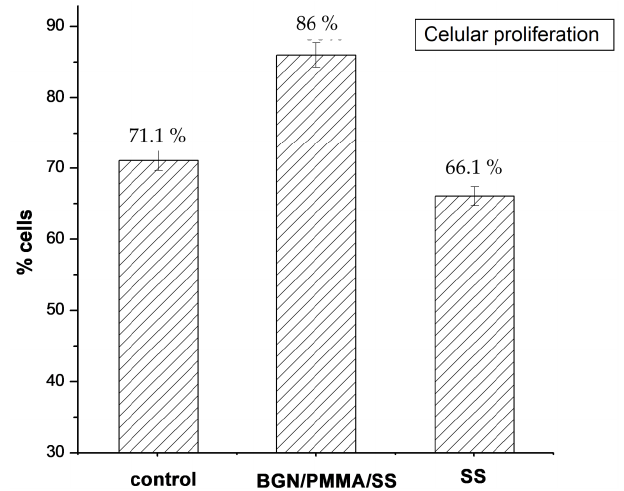
Figure 14. Proliferation of cells at passage 9 after 6 days from seeding on BGN / PMMA / SS and bare SS samples. Table 5. Antibacterial activity of the samples against Staphylococcus aureus and Escherichia coli.